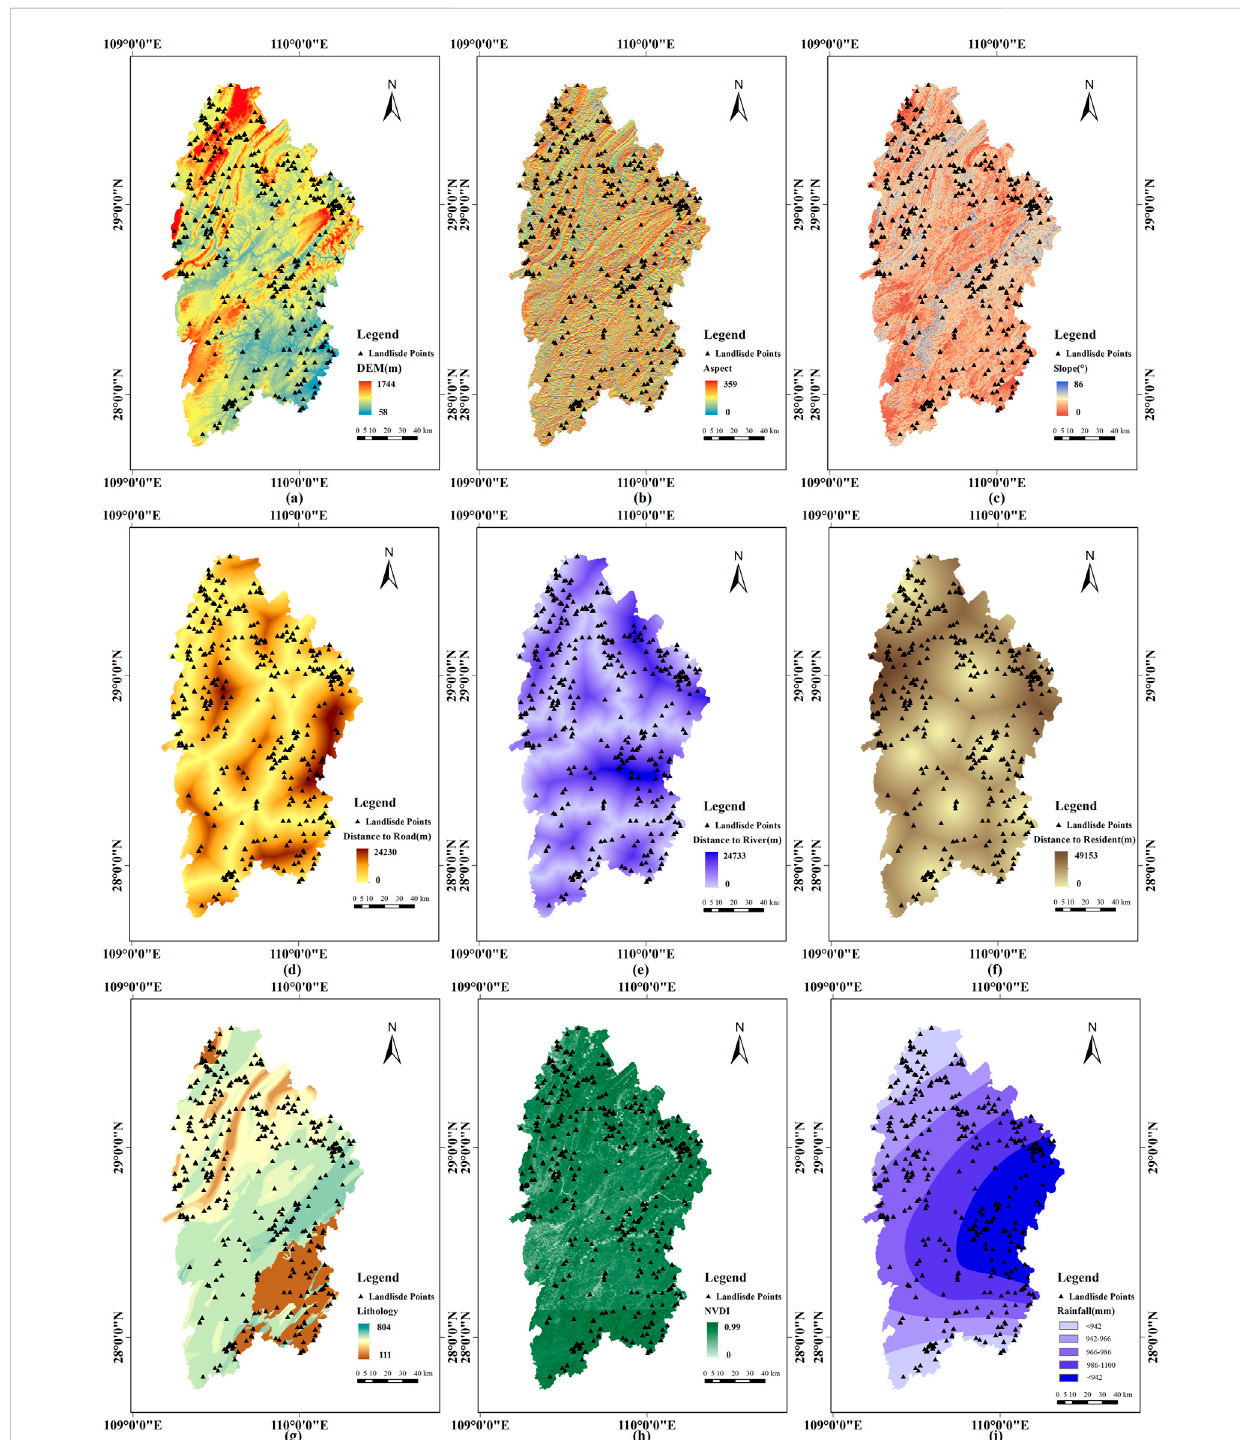
FIGURE 2 Diagrams of the landslide triggering